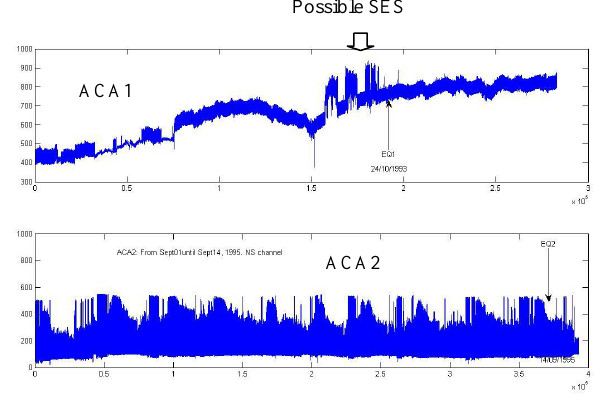
Figure 1. Acapulco time series. The thin downward arrows indicate the EQ1 and EQ2 occurrence.